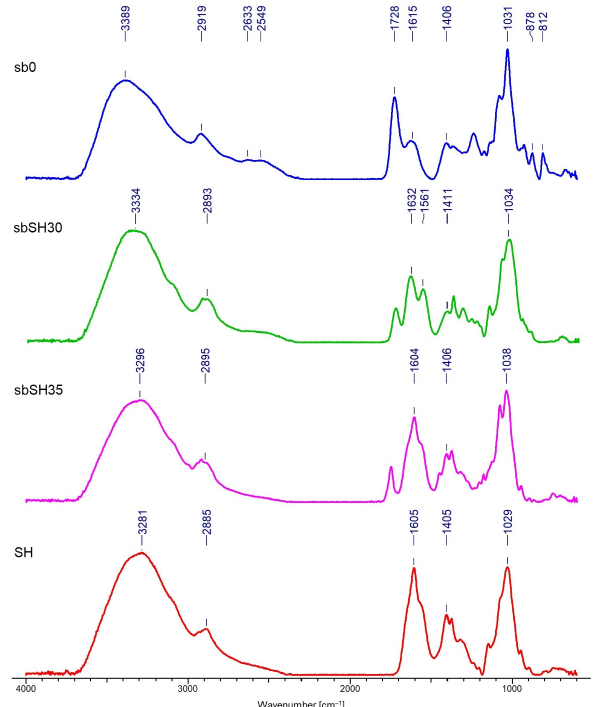
Figure 10. FTIR spectra of the spun-bonded PLA nonwoven fabrics with deposition of the sodium hyaluronate layer (SH): sb0—reference sample (spun-bonded PLA nonwoven); SH—powder of sodium hyaluronate. Materials 2022 , 15 , 7097 13 of 23